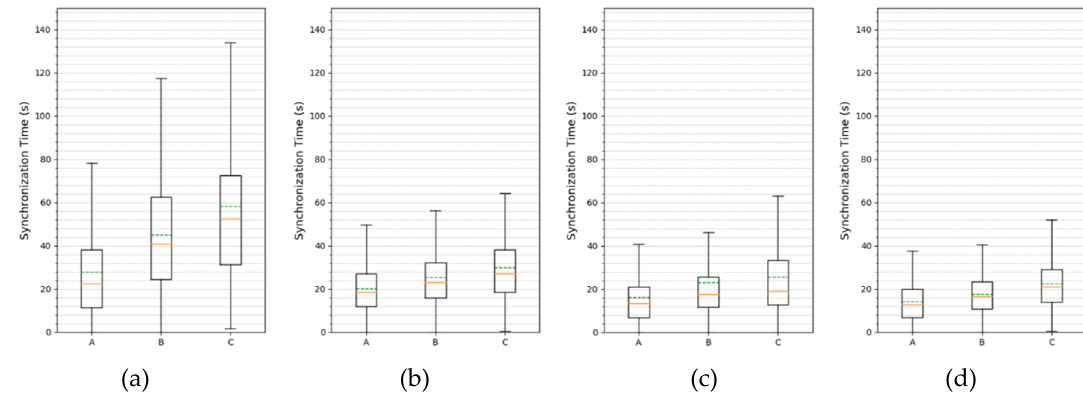
Figure 16. Distribution of Synchronization Time per Group Using 5 × 5 Mesh Topology ( a ) PS–TSCH ( b ) PRV–TSCH (Probability 33%) ( c ) PRV–TSCH (Probability 66%) ( d ) DRL–TSCH.